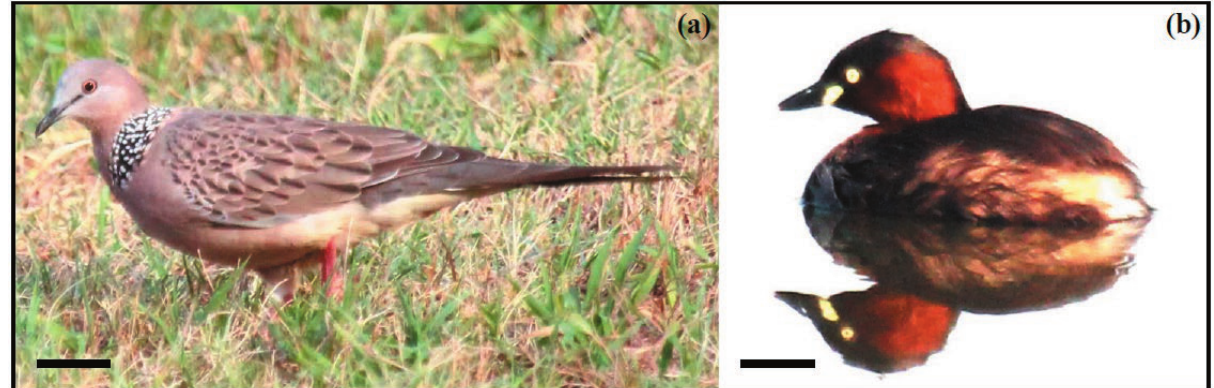
Figure 1. General characteristics of Spilopelia chinensis (a) and Tachybaptus ruficollis (b); scale bars = 5